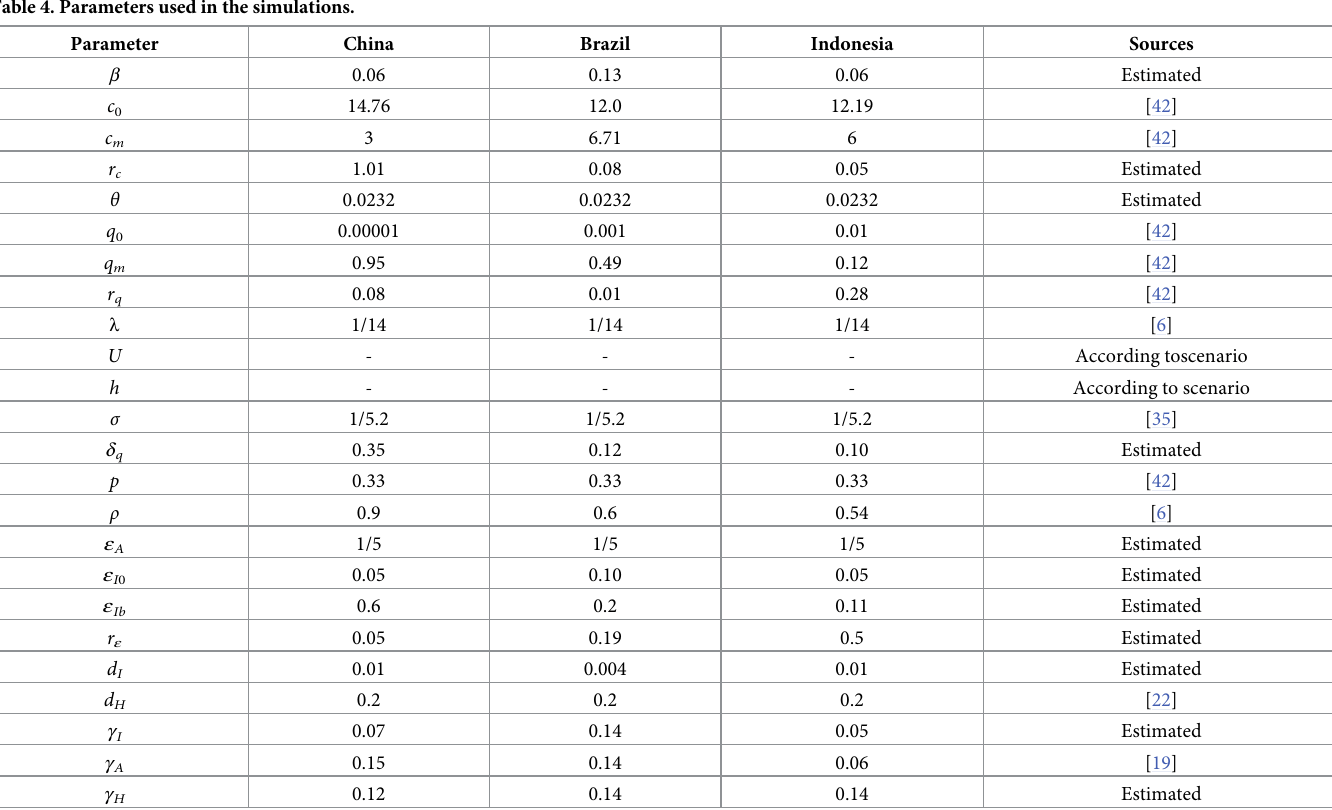
Table 4. Parameters used in the